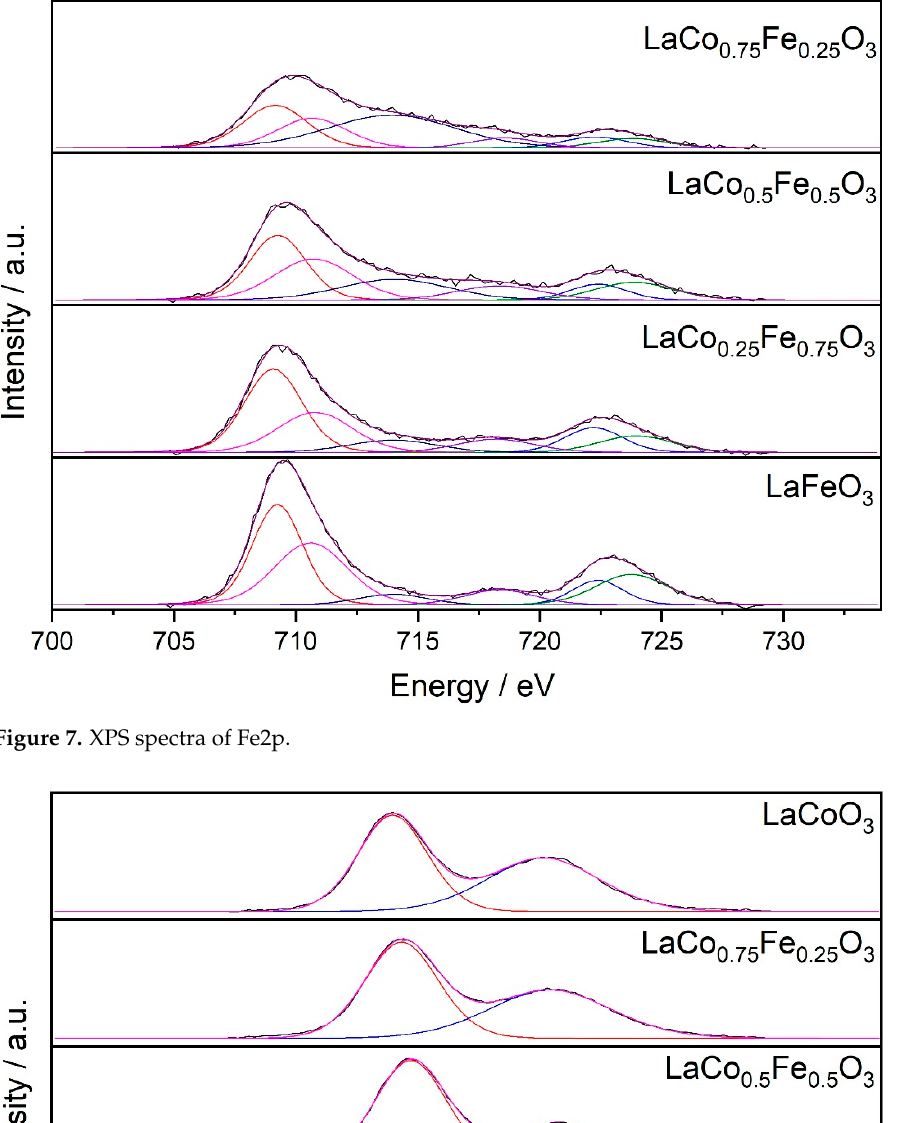
Figure 6. XPS spectra of Co2p.